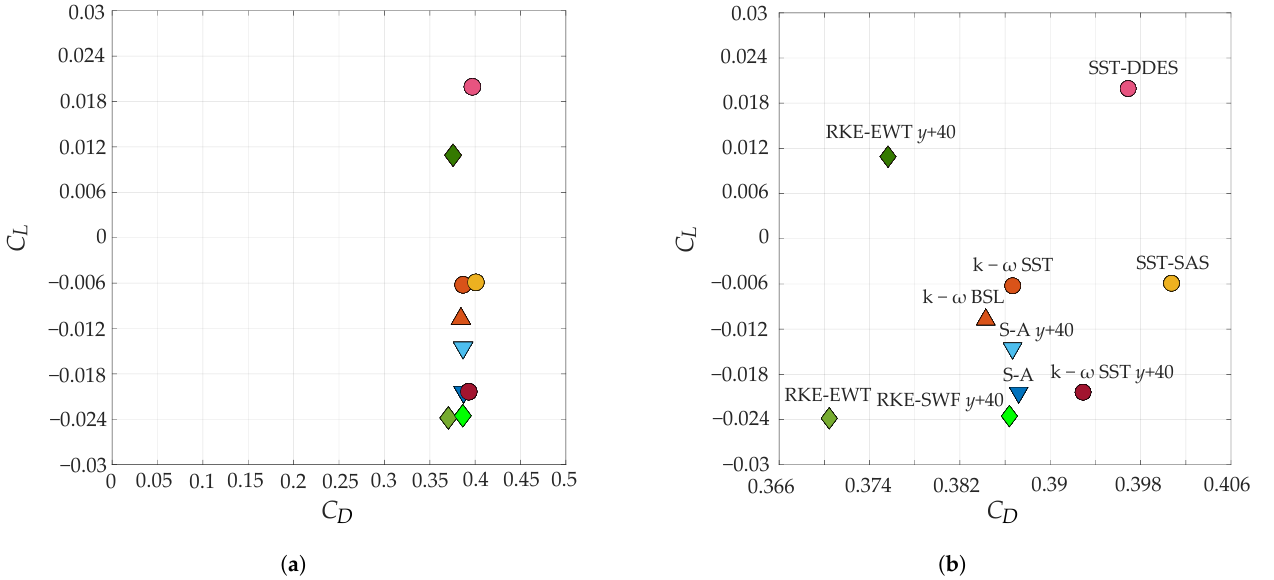
Figure 8. Values of aerodynamic drag coefficient ( C D ) and lift coefficient ( C L ) for different turbulence models ( a ), together with a close-up view on which the respective models are labelled ( b